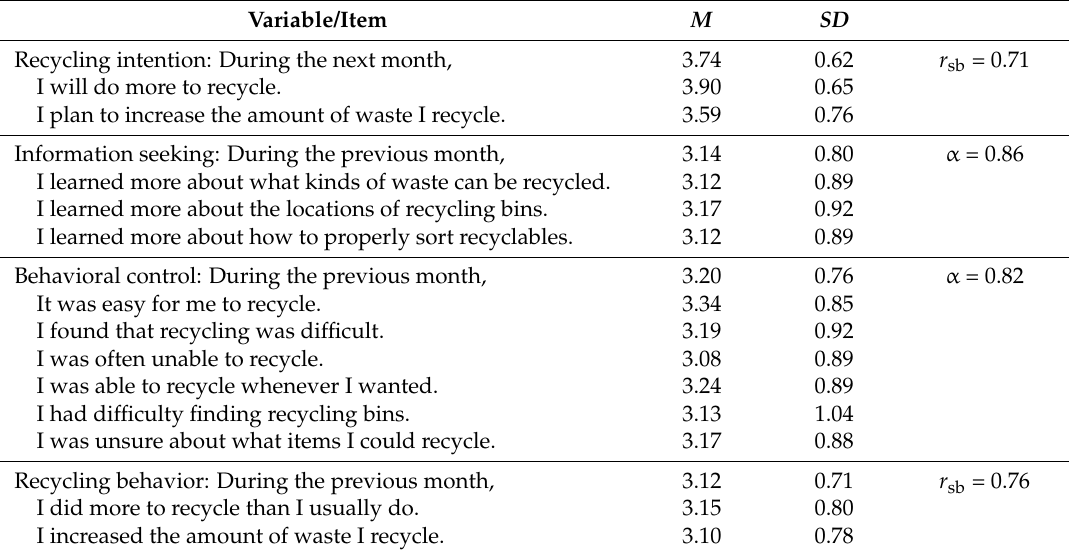
Table 1. Descriptive summary of variables and items.